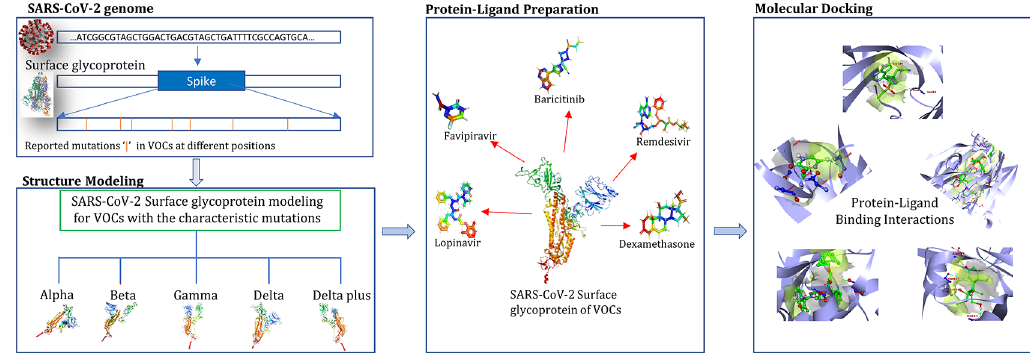
Figure 3. Summarized representation of the